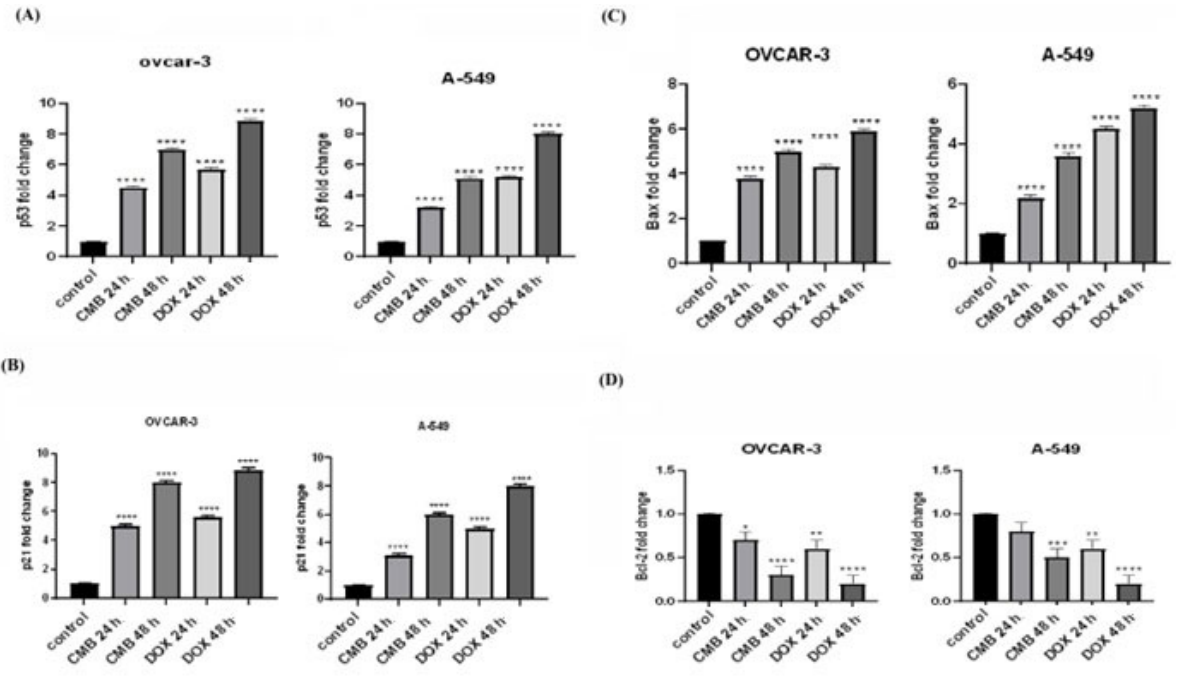
Figure 4. Molecular evaluation of gene expression in OVCAR-3 and A-549 cells after incubation with CMB or doxorubicin IC 50 values for 24 h or 48 h. Relative gene expression is represented as mean ± SEM. ( A ) P53 gene expression in OVCAR-3 and A-549 cells. ( B ) P21 gene expression in OVCAR-3 and A-549 cells. ( C ) Bax mRNA level in OVCAR-3 and A-549 cells. ( D ) Bcl2 mRNA level in OVCAR-3 and A-549 cells. Means and SE were calculated from three independent experiments. Statistically significant results compared to untreated control were displayed as: * p < 0.05; ** p < 0.01; *** p < 0.001; **** p < 0.0001.